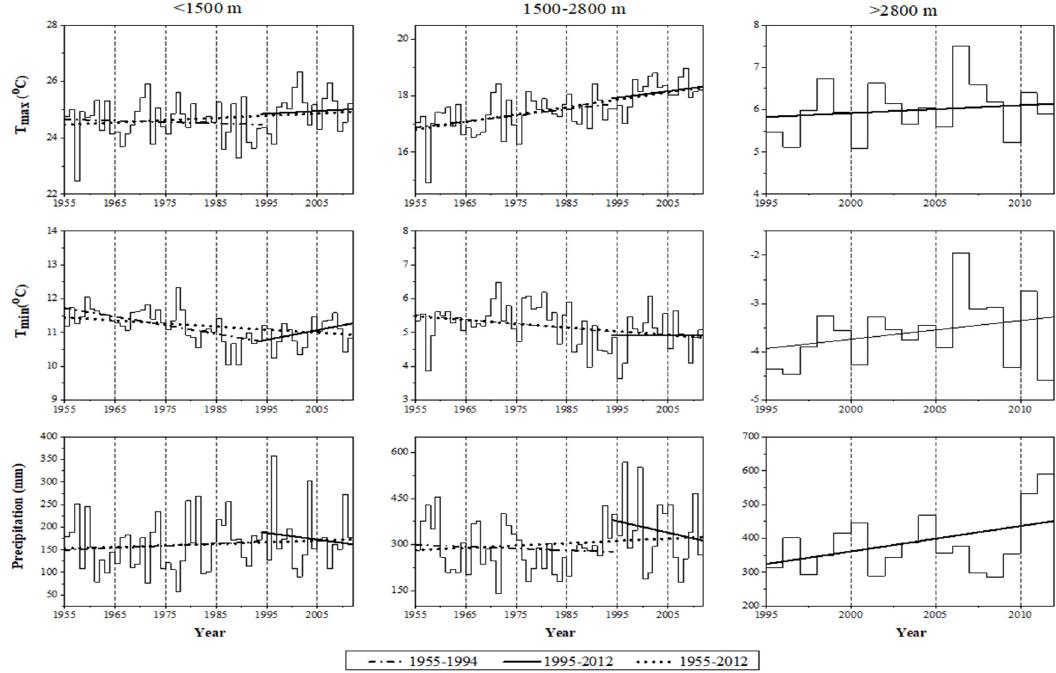
Figure 7. Trends of annual T max , T min and precipitation in different elevations (<1500 m, 1500–2800 m, >2800 m) during 1955–1994, 1995–2012 and 1955–2012. Corresponding slope during various periods are also mentioned. Temperature and precipitation slopes are mentioned in °C/decade and mm/decade respectively.